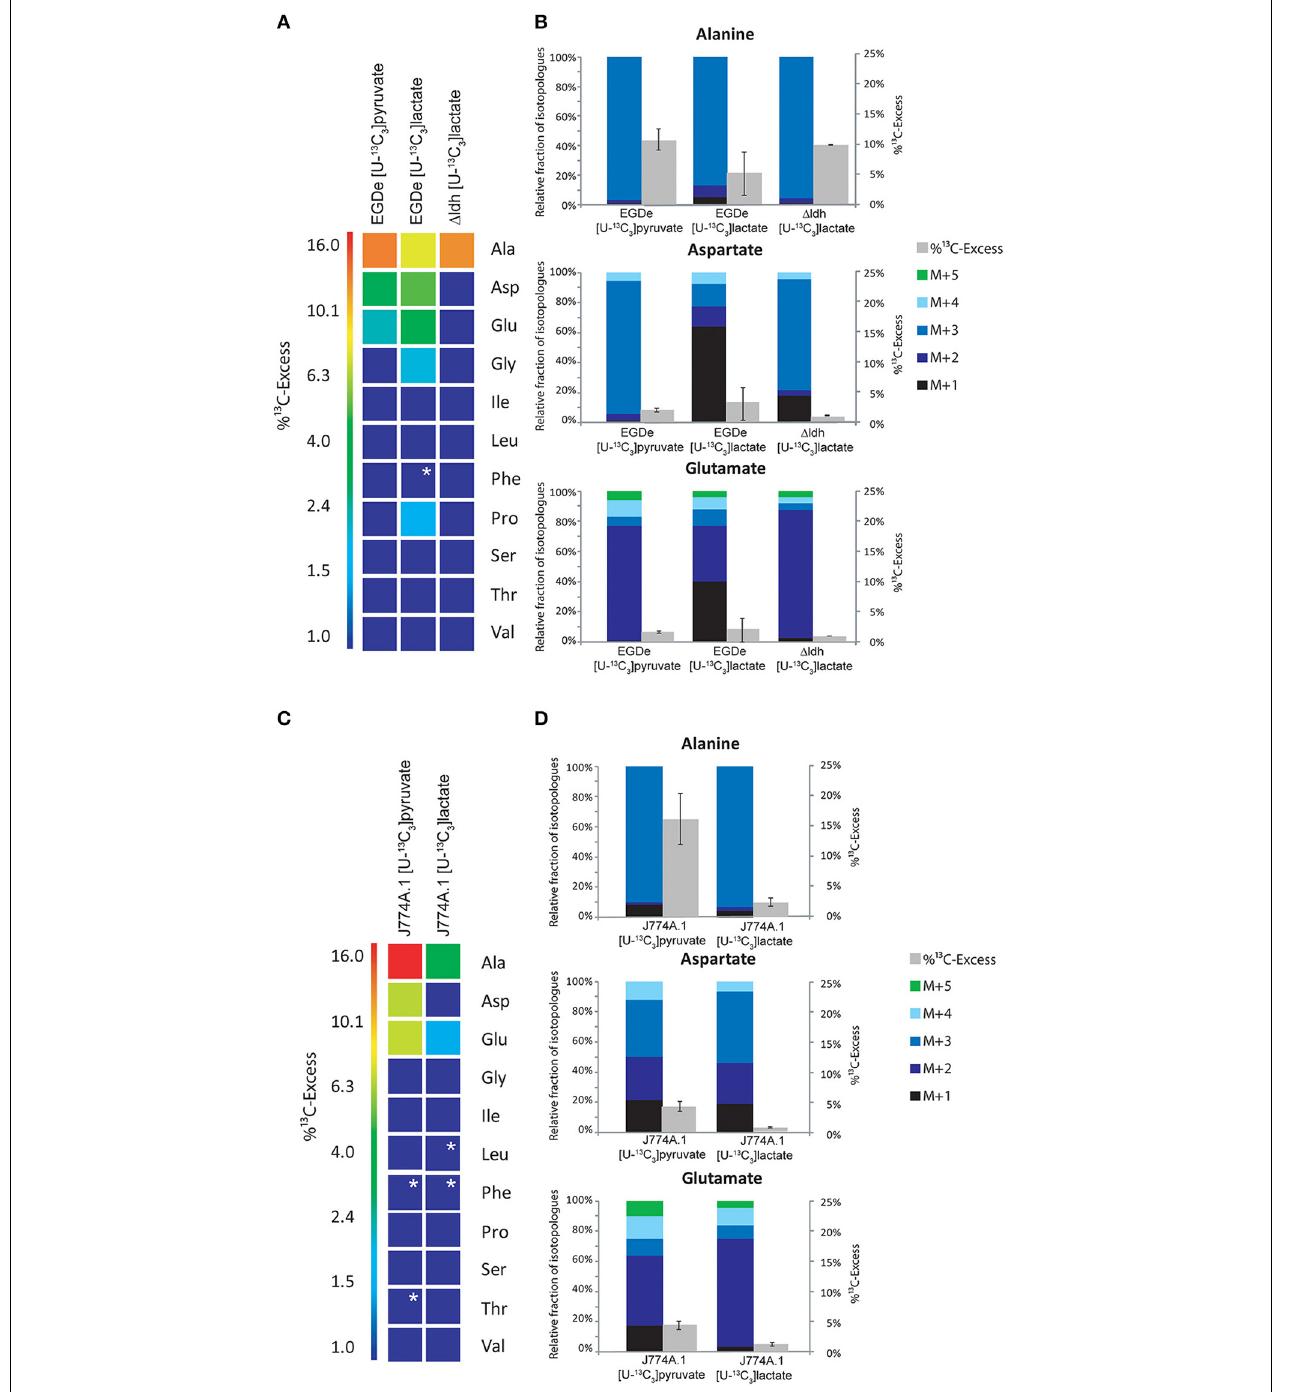
listerialAla,Asp,andGlu,respectively,fromthesameexperiments.Thecolored columns indicate the relative fractions (in %) of the 13 C-isotopologues (M + 1 to M + 5) in the labeled amino acids (left scales). For comparison, the gray bars indicatethe 13 C-excessvalueswiththestandarddeviationsfromthreetechnical replicates (right scales). (C) , 13 C-Excess (in %) of amino acids from J774A.1 proteins in the infection experiments with [U- 13 C 3 ]pyruvate or [U- 13 C 3 ]lactate. (D) , Isotopologue profiles of J774A.1 Ala, Asp, and Glu, respectively, from the same experiments. For the numerical values, see Supplemental